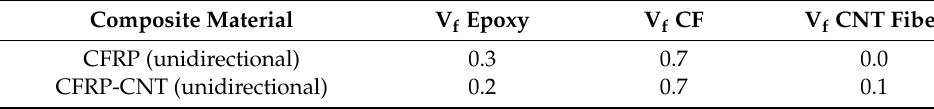
Table 1. Expected volume fractions of components in a CNT-CF composite.